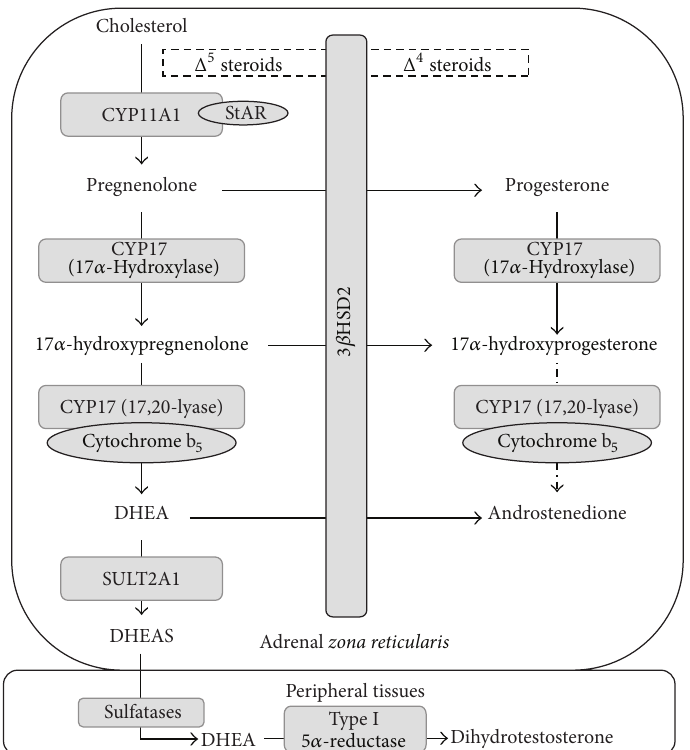
Figure 5: Steroidogenesis pathways and regulation in the adrenal zona reticularis . 3 𝛽 HSD2: 3 𝛽 -hydroxysteroid dehydrogenase 2; CYP11A1: cholesterol side-chain cleavage enzyme; CYP17: 17 𝛼 -hydroxylase/17,20 lyase; DHEA: dehydroepiandrosterone; DHEAS: dehydroepiandros- terone sulfate; StAR: Acute Steroidogenic Regulatory Protein. After CYP11A1 acts on cholesterol, pregnenolone may undergo both functions of CYP17 (17 𝛼 -hydroxylation and 17,20-lyation, the latter with cytochrome b 5 as a cofactor), rendering DHEA as a product. DHEA synthesis is favoredinthe zonareticularis becausethe17,20-lyasefunctionactspreferentiallyon Δ 5 steroids,whoseproductionispotentiatedinadrenarche due to 3 𝛽 HSD2 underexpression. Additionally, upregulated SULT2A1 expression augments DHEA sulfonation, preventing conversion to other metabolites. DHEAS is secreted and reconverted to DHEA by sulfatases in peripheral tissues, where it also undergoes type 5 𝛼 -reductase catalysis and then exerts its